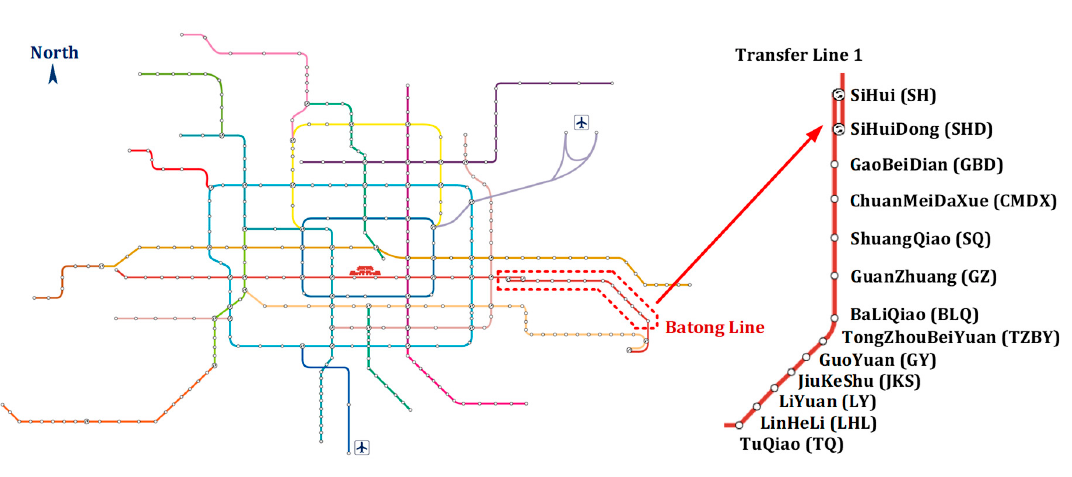
( b ) Figure 7. Statistical results of daily passenger volume in weekdays and weekend days. ( a ) Results in weekdays; ( b ) Results in weekend days. Based on the prepared data sets, the energy efficient train driving control profile calculation and boundary identification are performed and the results are given in the following sections. 4.2. Energy Efficiency Improved by BFO-based Solution